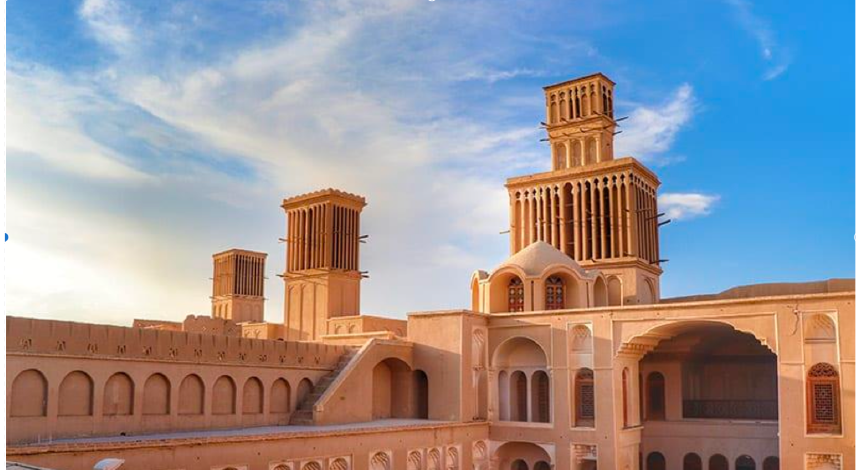
Figure 13. Example of Iranian wind